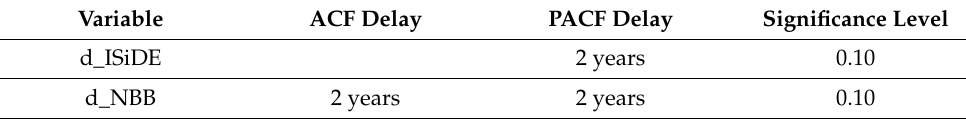
Table 4. Autocorrelations and partial autocorrelations of variables.